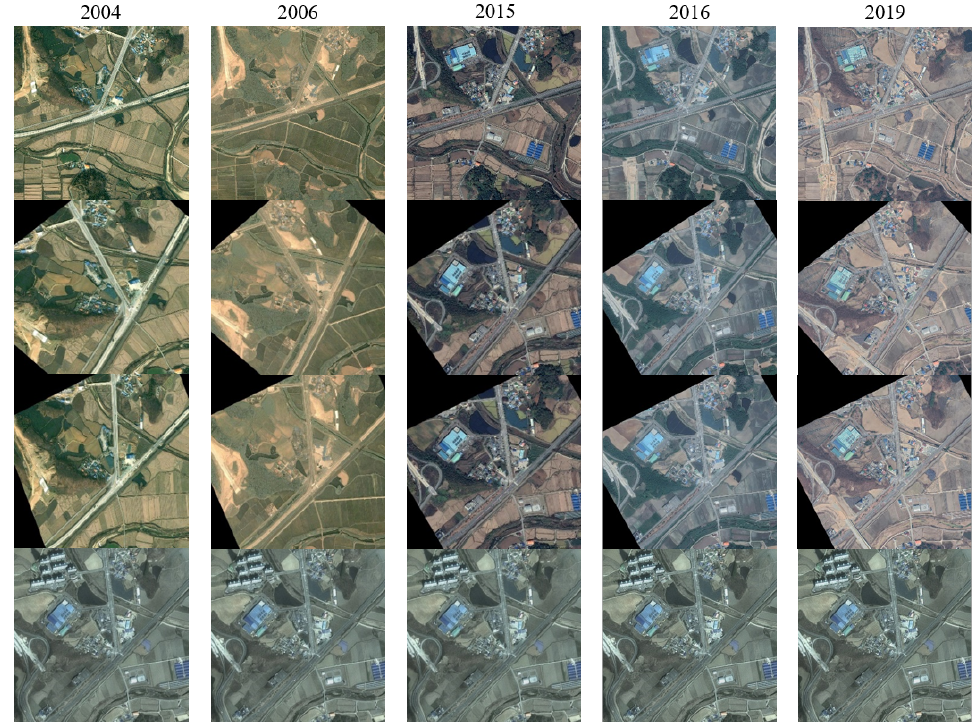
Figure 12. Results for various source images taken at different times. Rows are each as follows: